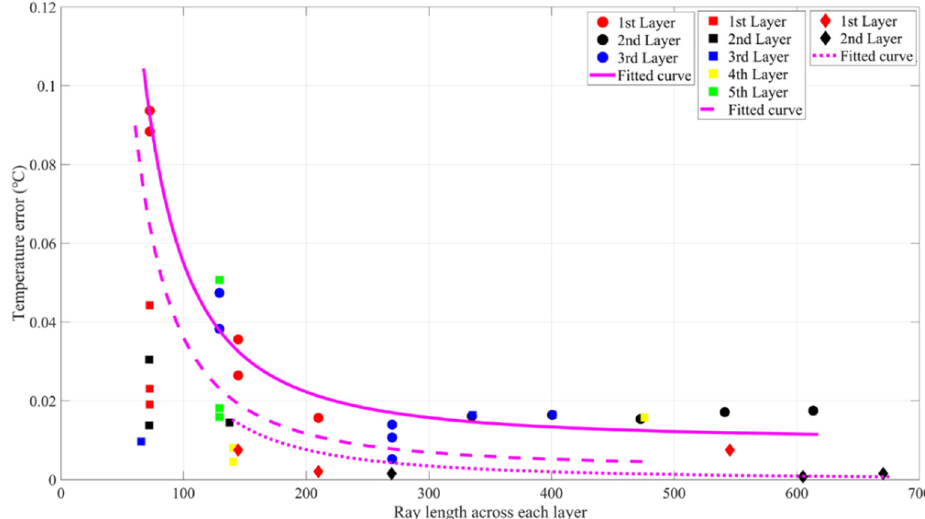
Figure 19. Relationship between the ray length across each layer and the inversion errors. The meanings of the labels are the same as in Figure 17.